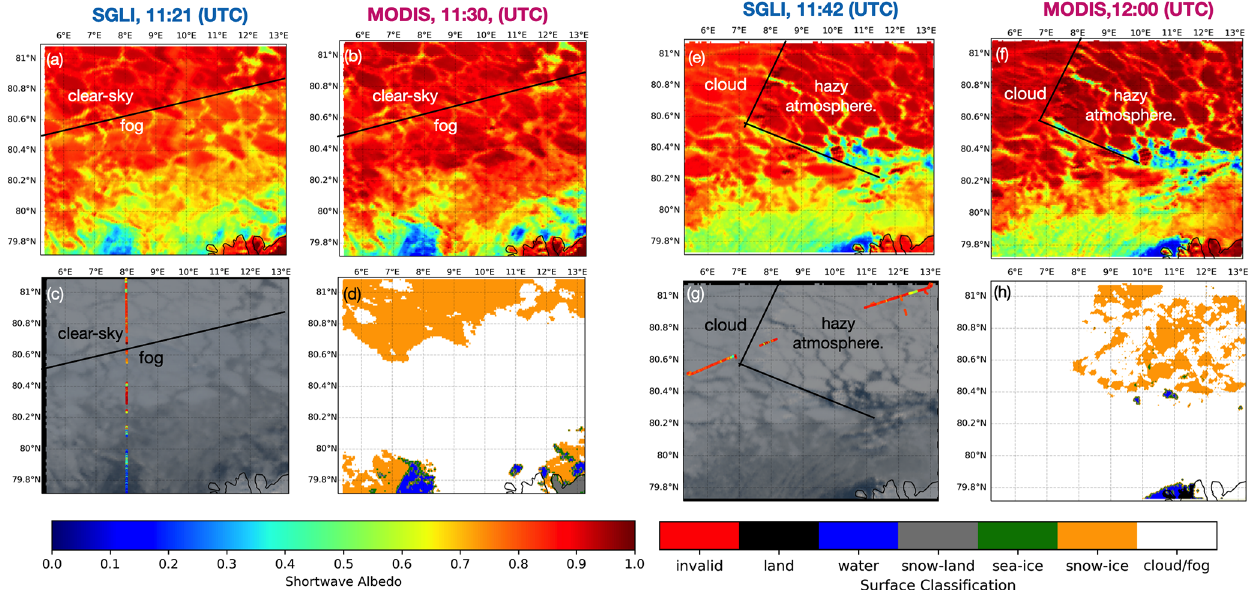
Figure 5. Albedo retrieval maps, RGB maps, and surface classification maps from 8 April 2019 (a–d) and 11 April 2019 (e–h) . Panels (a) and (e) represent the albedo values retrieved with the SGLI sensor, (b) and (f) represent the albedo values retrieved with the MODIS sensor, (c) and (g) represent the spatial overlay of surface albedo measurements made on low-level ( ≤ 350m) flights (dots) on true color composite images, and (d) and (h) represent the surface classification results. The black lines represent the distinctions between various atmospheric conditions.